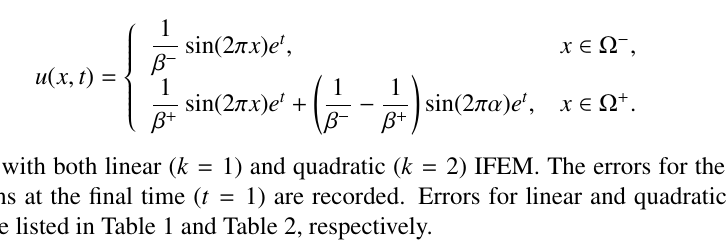
Table 1. Errors for Linear IFEM at final time for β + = 1 and β − = 5, ∆ t = h / 3 h